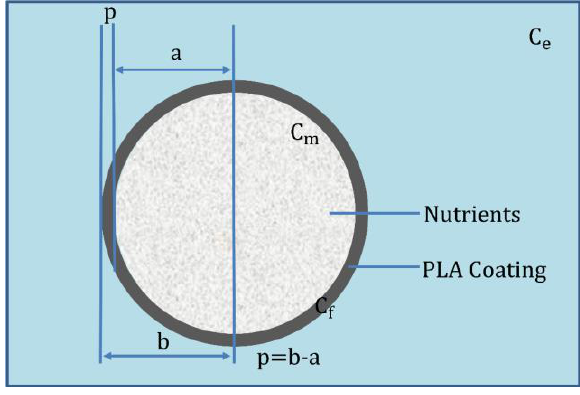
Figure 1. Schematic of the CRF.